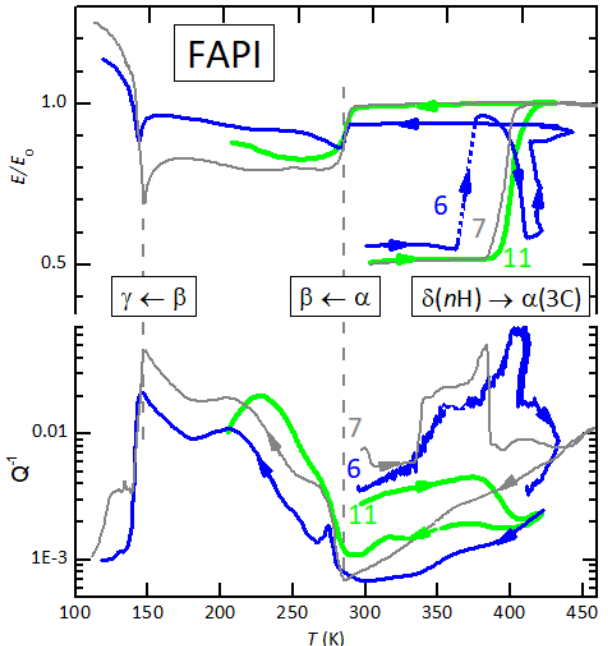
Figure 2. Relative change of the Young’s modulus and elastic energy loss vs. T of FAPI #6 (old hydrated powders) and FAPI #11; the heating rate was 0.5 K/min in high vacuum. Furthermore, reported for reference is the measurement of FAPI #7 of Figure 1 (+1.5 K/min in 7 mbar H 2